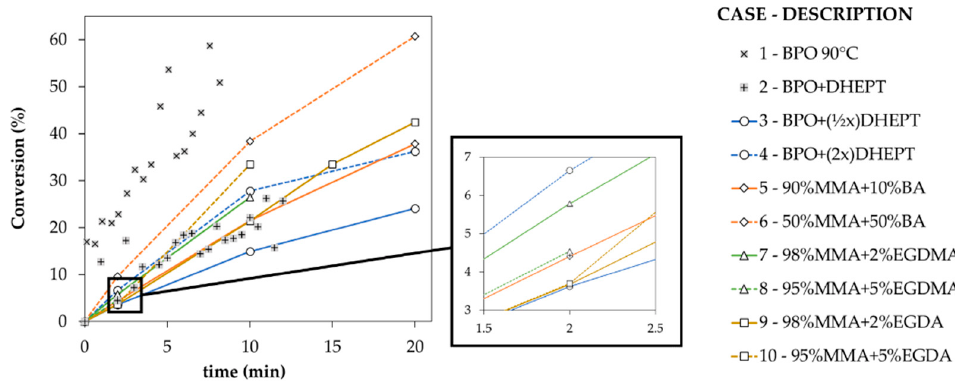
Figure 4. Conversion, as the percentage MMA consumed, versus time for 10 coformulation cases as defined in Table 1. Case 1 starts at 90 °C; other cases at room temperature; full vs. dashed line: lower vs. higher amount.